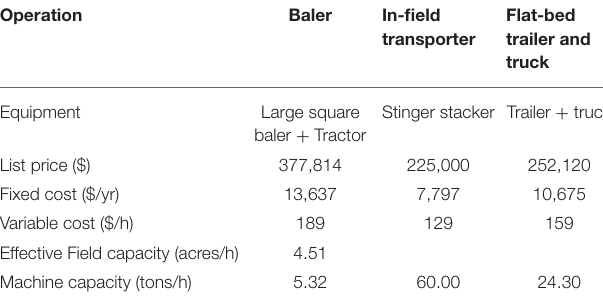
TABLE 3 | Fixed and variable costs of equipment considered in this